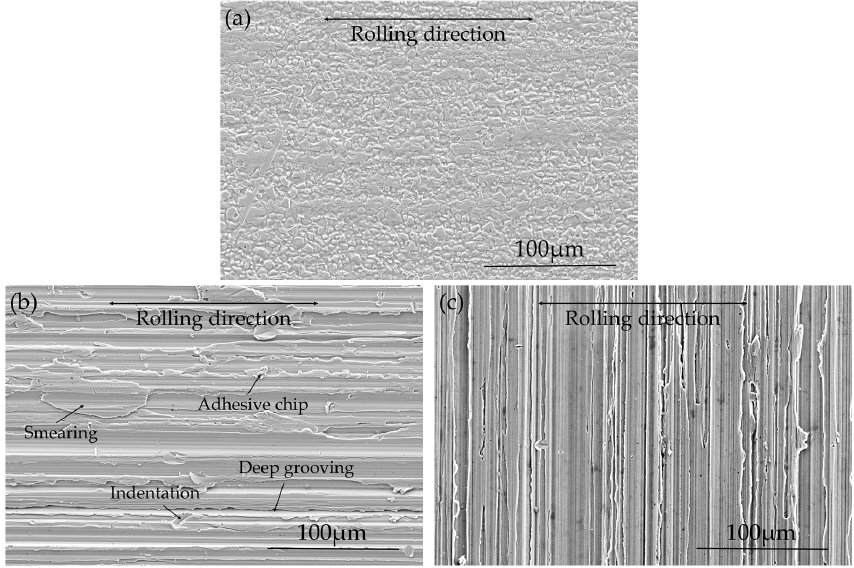
Figure 3. Surface topography of” ( a ) AD specimen; ( b ) Ground-RD specimen; and ( c ) Ground-TD specimen. Table 3. Measured surface roughness of AD, Ground-RD and Ground-TD specimens.